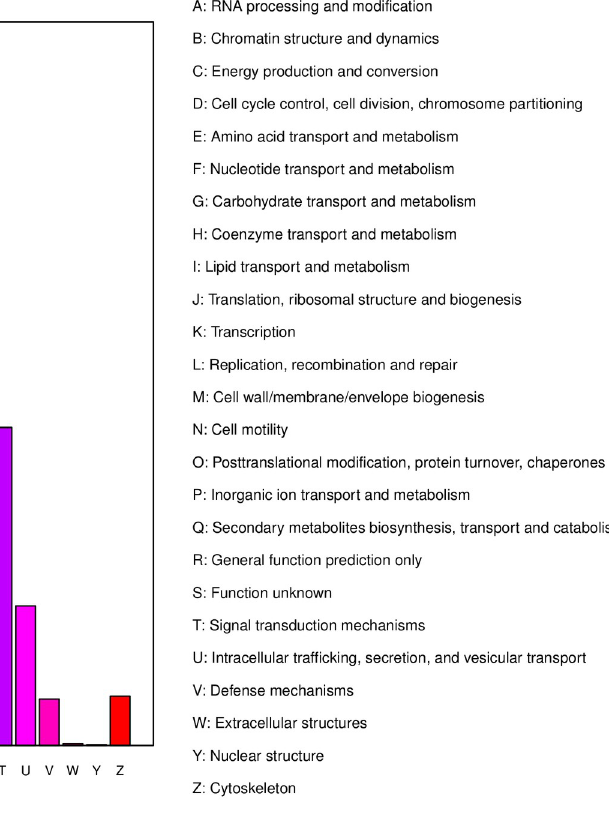
Fig 2. The Clusters of Orthologous Groups (COG) functional classification of all unigene of Coix lacryma-jobi L.